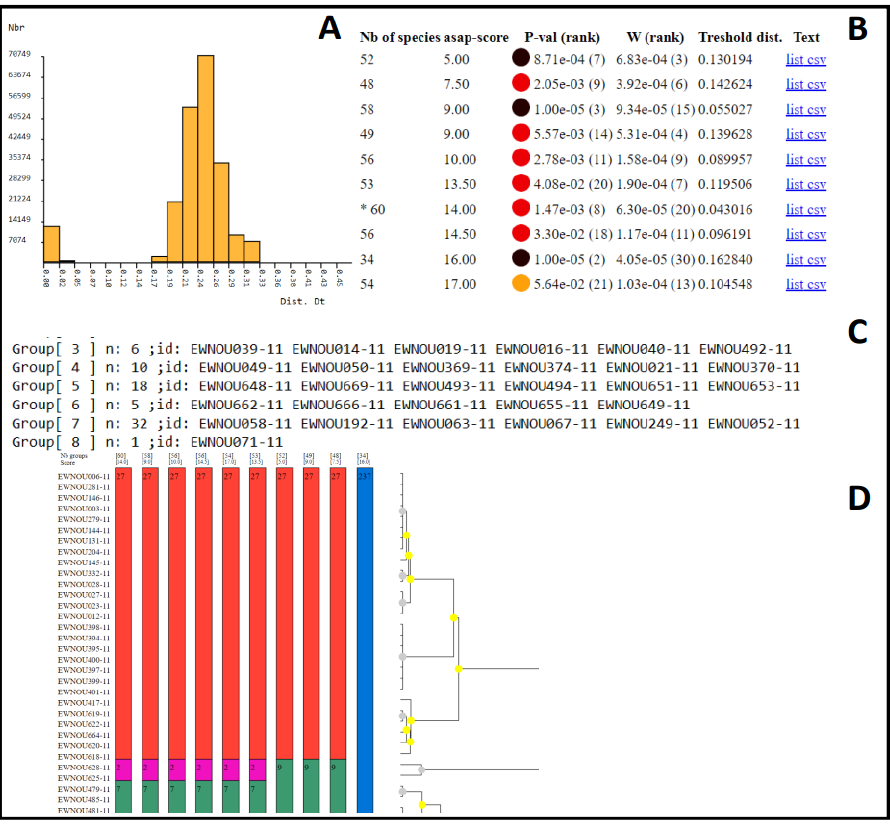
Figure 5. Output results obtained with the ASAP method: ( A ) diagram showing the distribution of pairwise genetic distances (K2P) between the sequences of dataset 1; ( B ) list of the 10 delimitations with the best ASAP scores; ( C ) extract from the text file showing the distribution of sequences from dataset 1 in the OTUs; and ( D ) extract graphical output showing the different delimitations together with the ultrametric clustering tree; each column in D represents a partition, and the colors represent the OTUs.